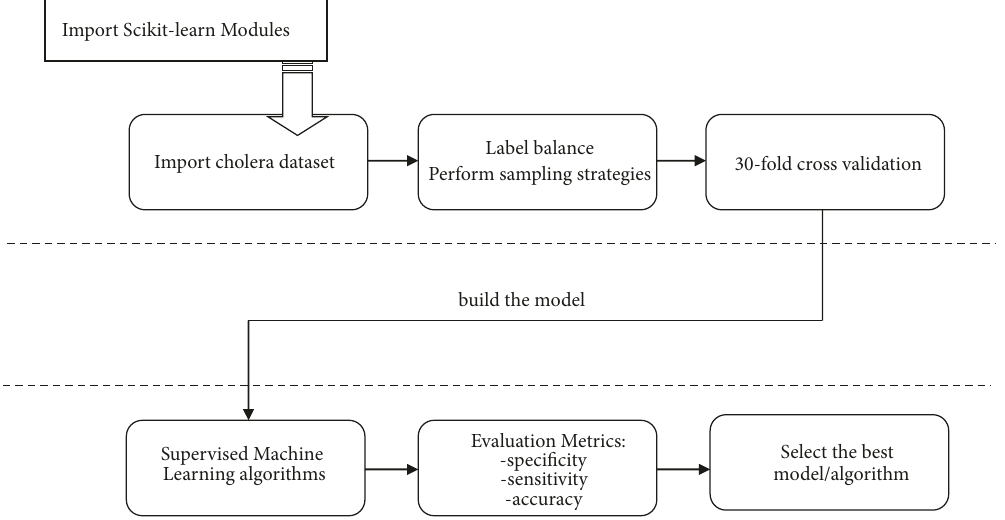
Figure 5: Model formulation